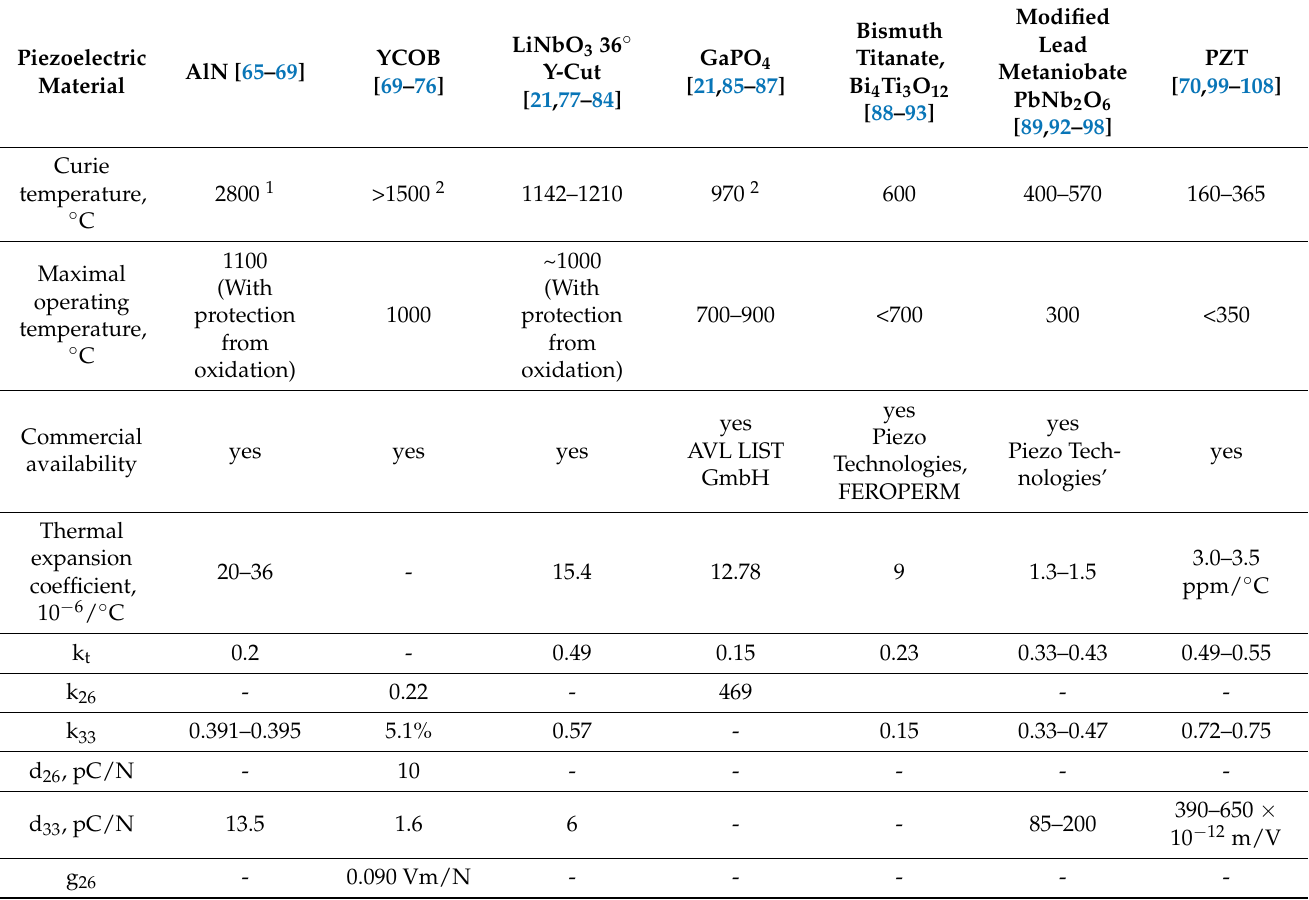
Table 3. Piezoelectric materials and their